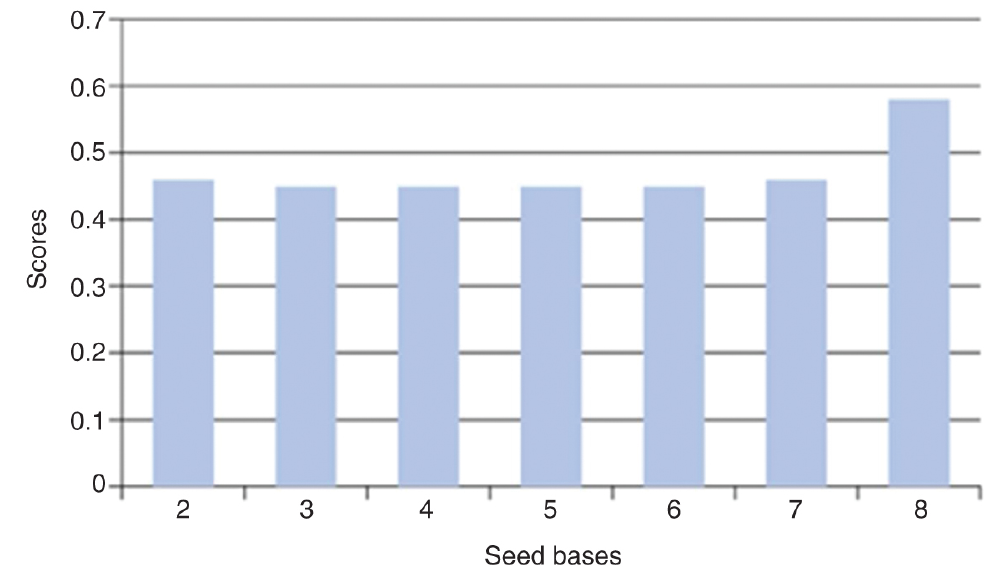
Figure 3: Average miR2GO scores by miRNA seed positions (nucleotide bases) from all possible seed mutations. Interestingly, the ten top ranked seed mutations are all “ C->T ” (C/U) mutations (Table 1). Supplementary